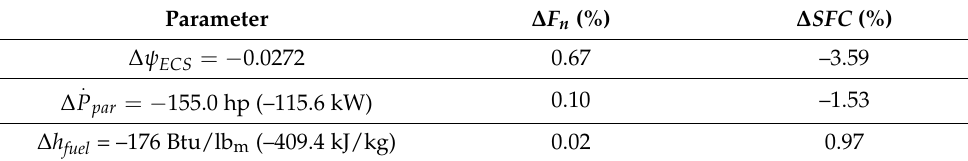
. P para , h fuel impact on Table 9. ψ ECS ,